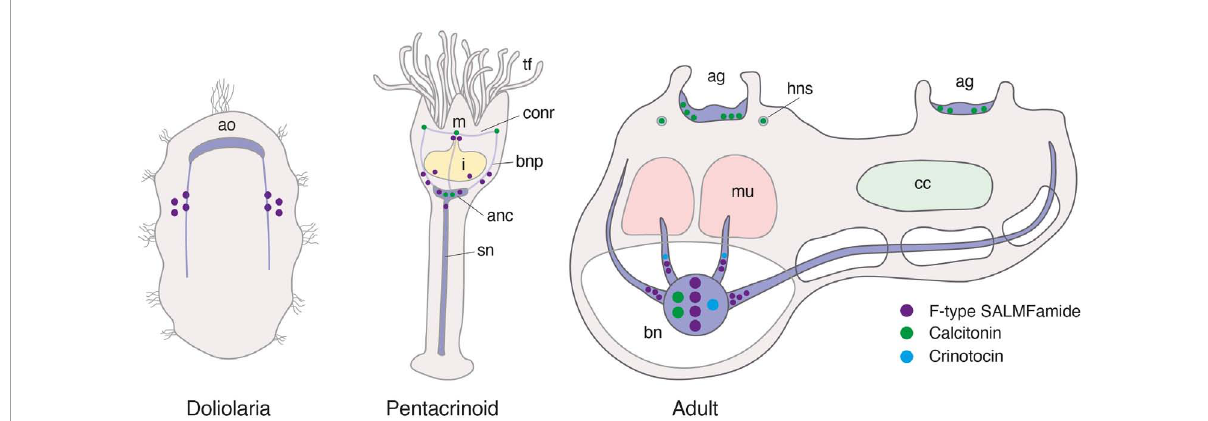
FIGURE14 Summary of neuropeptide expression in Antedon mediterranea . The distribution of cells expressing F-type SALMFamide (purple, mRNA in situ ); calcitonin-type neuropeptide (green, immunohistochemistry and mRNA in situ ); and crinotocin (cyan, mRNA in situ ) is summarized here for doliolaria larva, pentacrinoid and adult stages and related to the major compartments of the nervous system (blue). ag, ambulacral groove; anc, aboral nerve center; ao, apical organ; bn, brachial nerve; bnp, brachial nerve primordia; cc, coelomic canal; conr, circumoral nerve ring; hns, hyponeural system i, intestine; m, mouth; mu, muscles; sn, stalk nerve; tf, tube